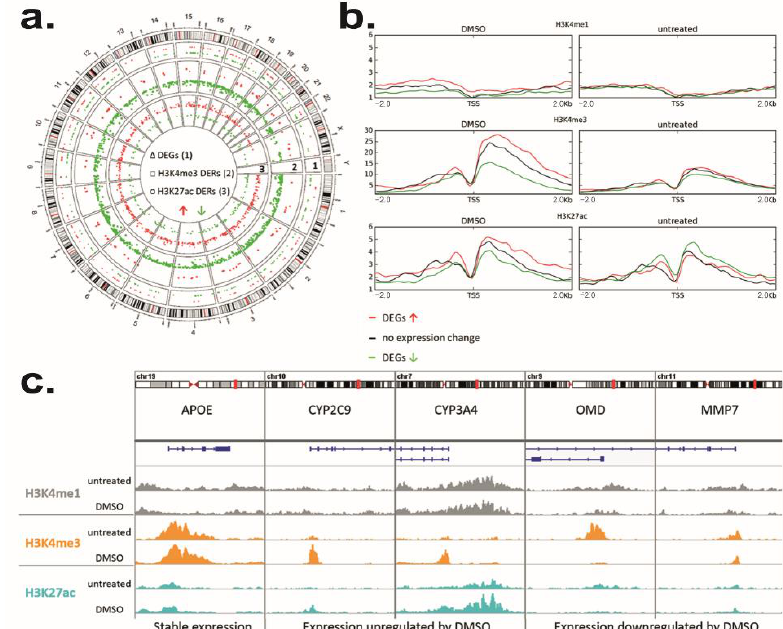
Figure 4. DMSO effect on genome-wide histone modification patterns in HepaRG differentiation. ( a ) Genome-wide distribution of DEGs (1, p < 0.005, FC> 2), H3K4me3 differentially enriched regions (DERs, 2) and H3K27ac DERs (3) upon DMSO exposure (padj< 0.001, FC > 2). Increase in expression or enrichment is colored in red, decrease in green. DERs are plotted as log2 fold changes ranging